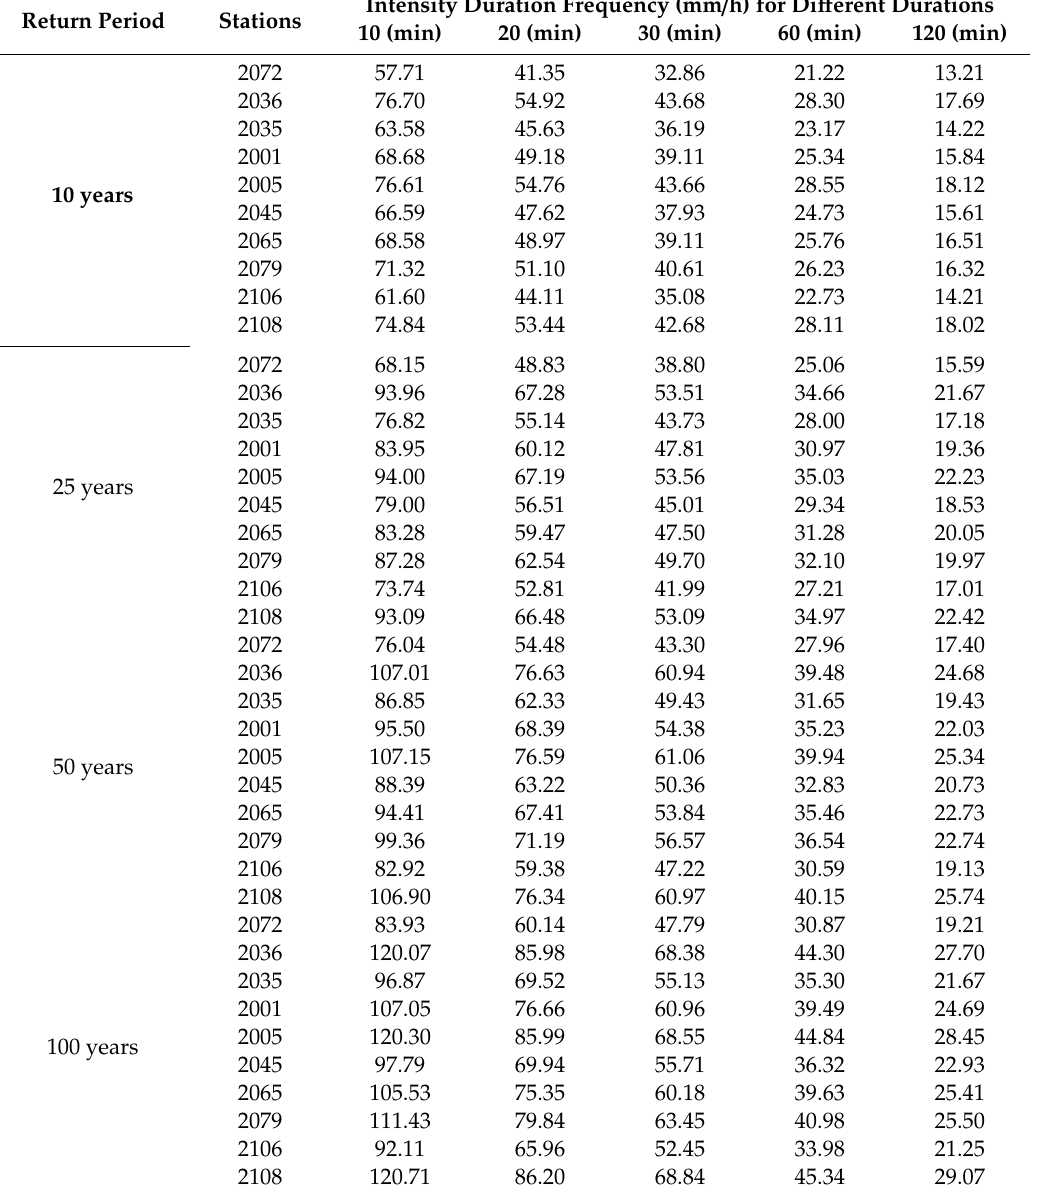
Table 7. IDF relationship selected for the rain gauge stations estimated through the Chen Method with the ( R ) ratio proposed in this